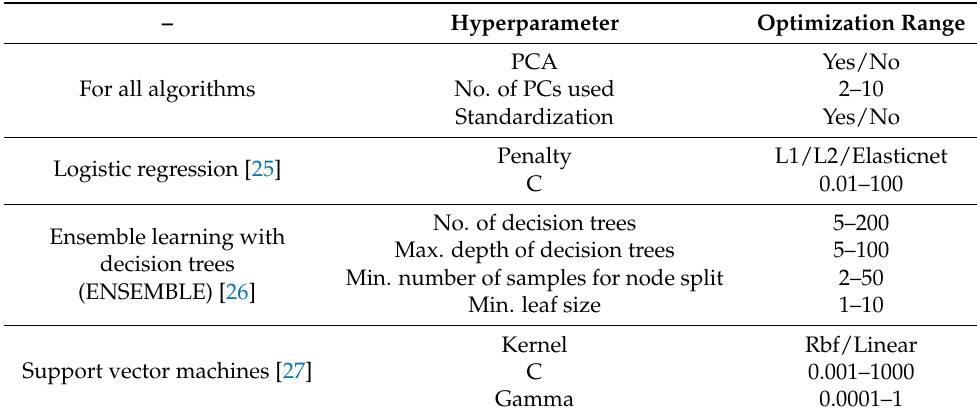
Table A1. Overview of the optimized hyperparameters and the optimization ranges of machine learning models. For a description of the hyperparameters, please refer to the literature